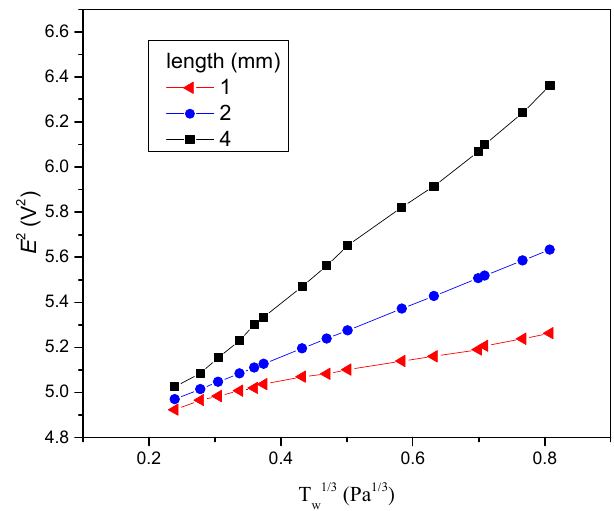
Figure 7. Sensitivity of the flexible hot film shear stress sensor with di ff erent lengths. Estimated accuracy for E 2 is ± 4 percent, for τ W1/3 , ± 4 percent.